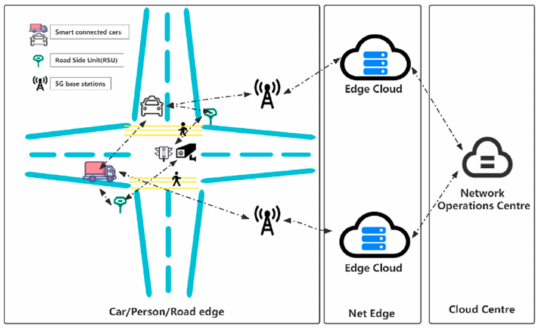
Figure 5. Internet of Vehicles Edge Computing